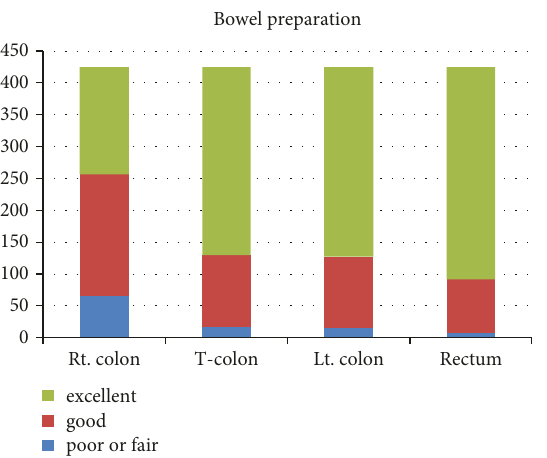
Figure 3: The degree of bowel preparation in each bowel